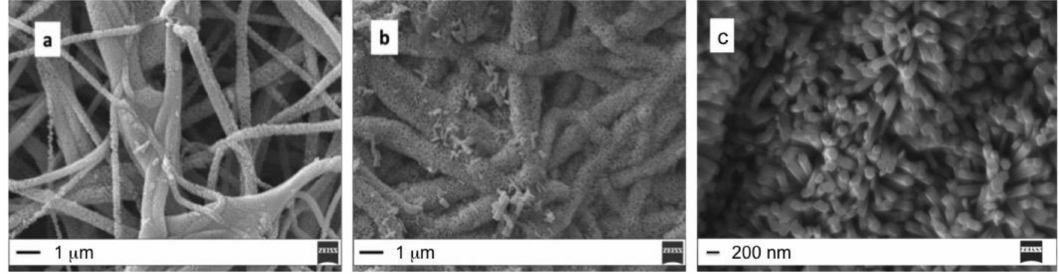
Figure 2. ( a ) Seed 1h, annealing 180 ◦ C 1 h, CBD 30 min; ( b ) Seed 1 h, annealing 180 ◦ C 1 h, CBD 1 h